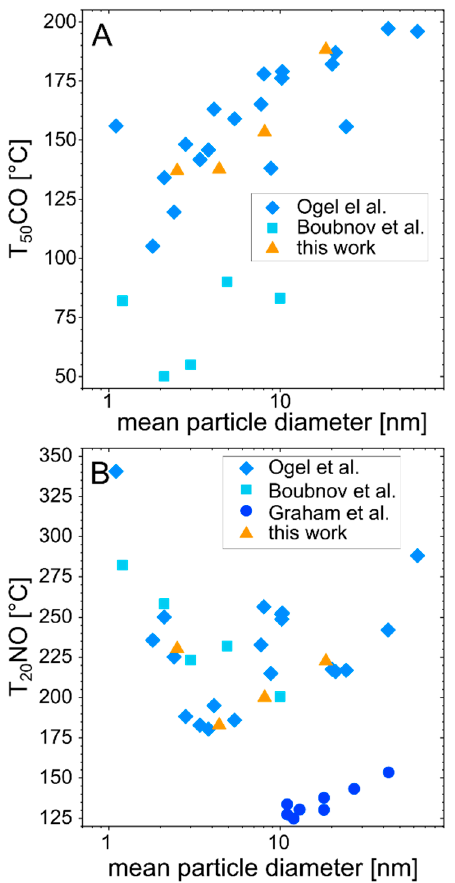
Figure 6. Size dependency of the ( A ) CO and ( B ) NO conversion of laser-generated catalysts; the orange triangles represent the conversion temperatures determined in this work and the blue data points are taken from the literature [3,5,9,64].